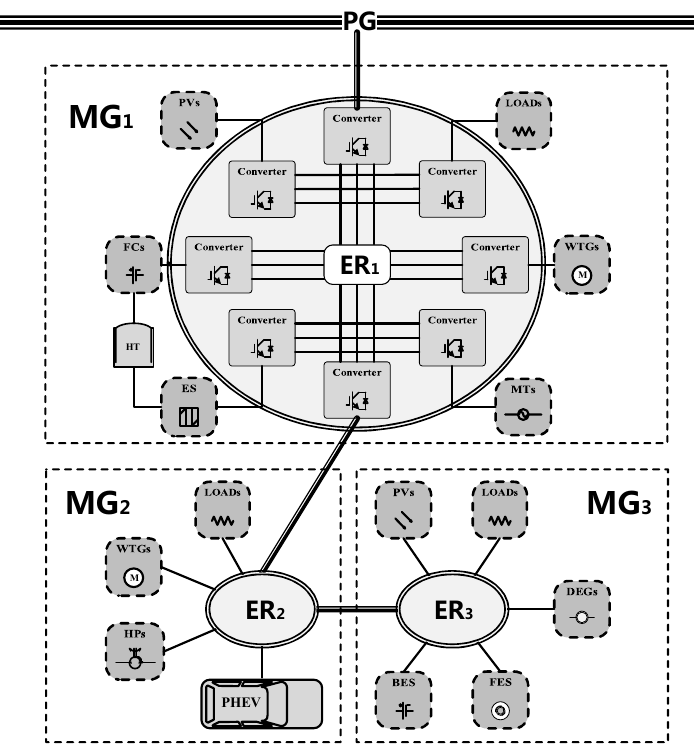
Figure 1. The studied series-shaped energy Internet (EI) system.